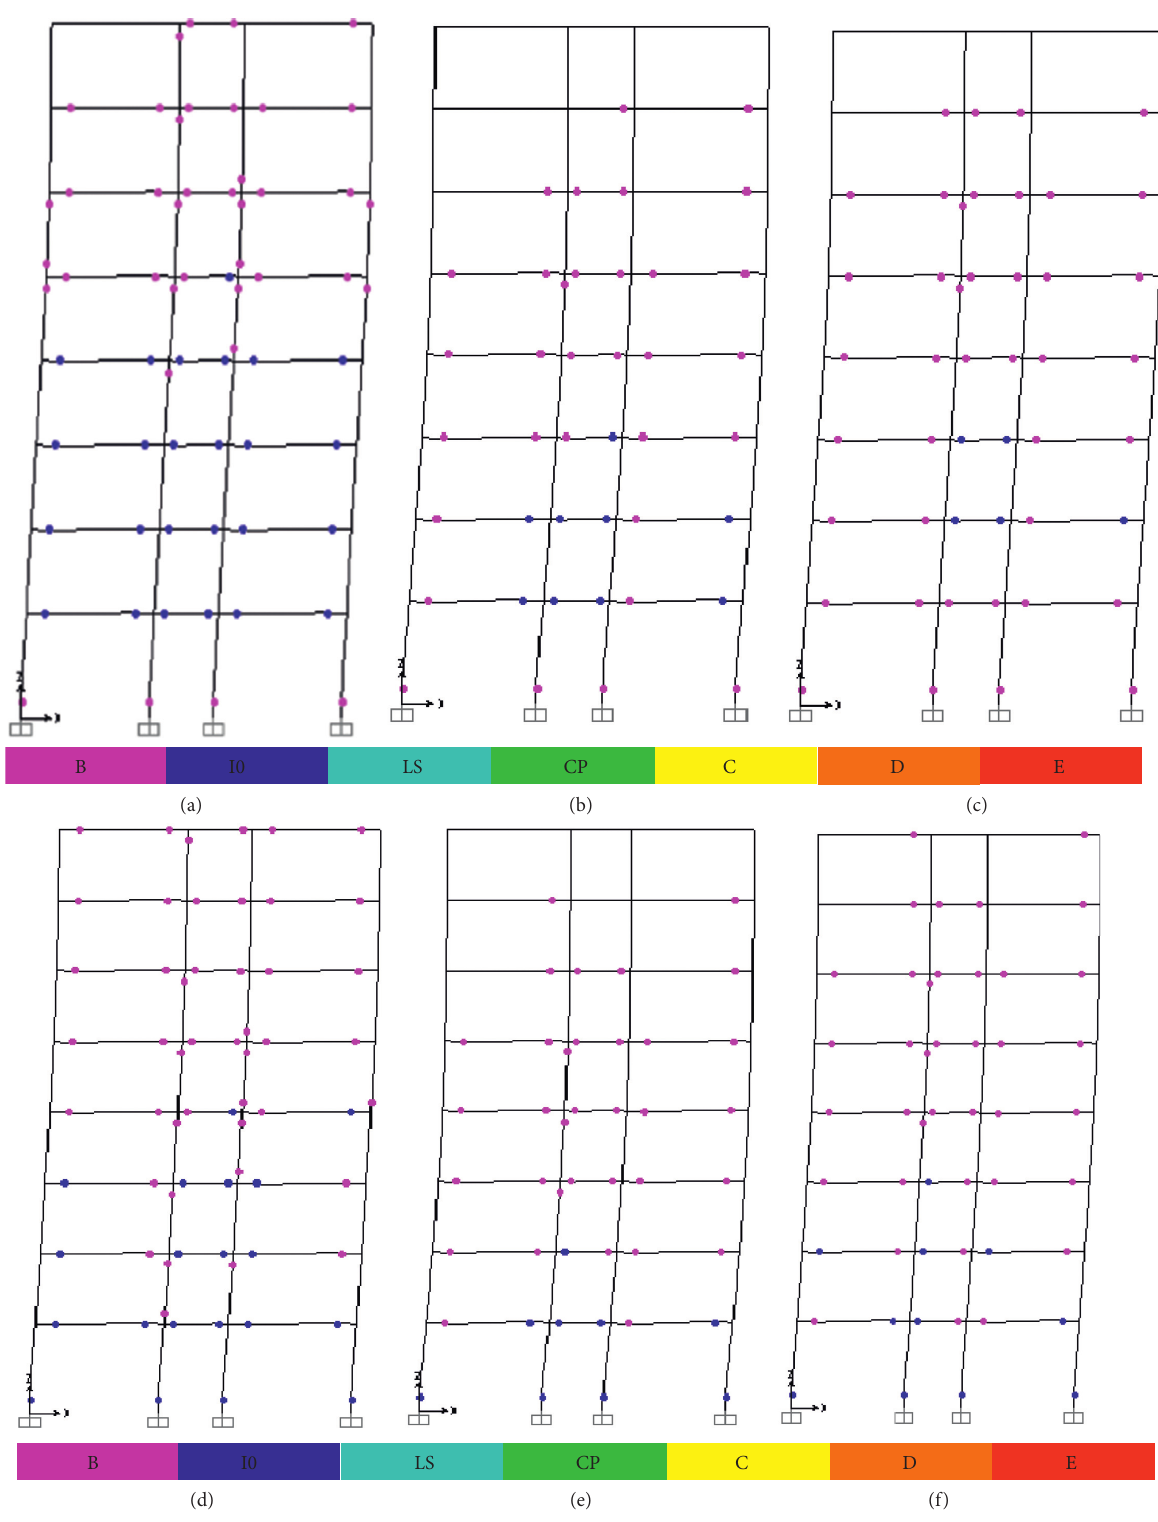
Figure 9: State of the plastic hinges in Models 8A and 8B: NL-THA and SPO analyses. (a) 8A-NL-THA. (b) 8A-SPO Uniform. (c) 8A-SPO- Mode-1. (d) 8B-NL-THA. (e) 8B-SPO Uniform. (f)